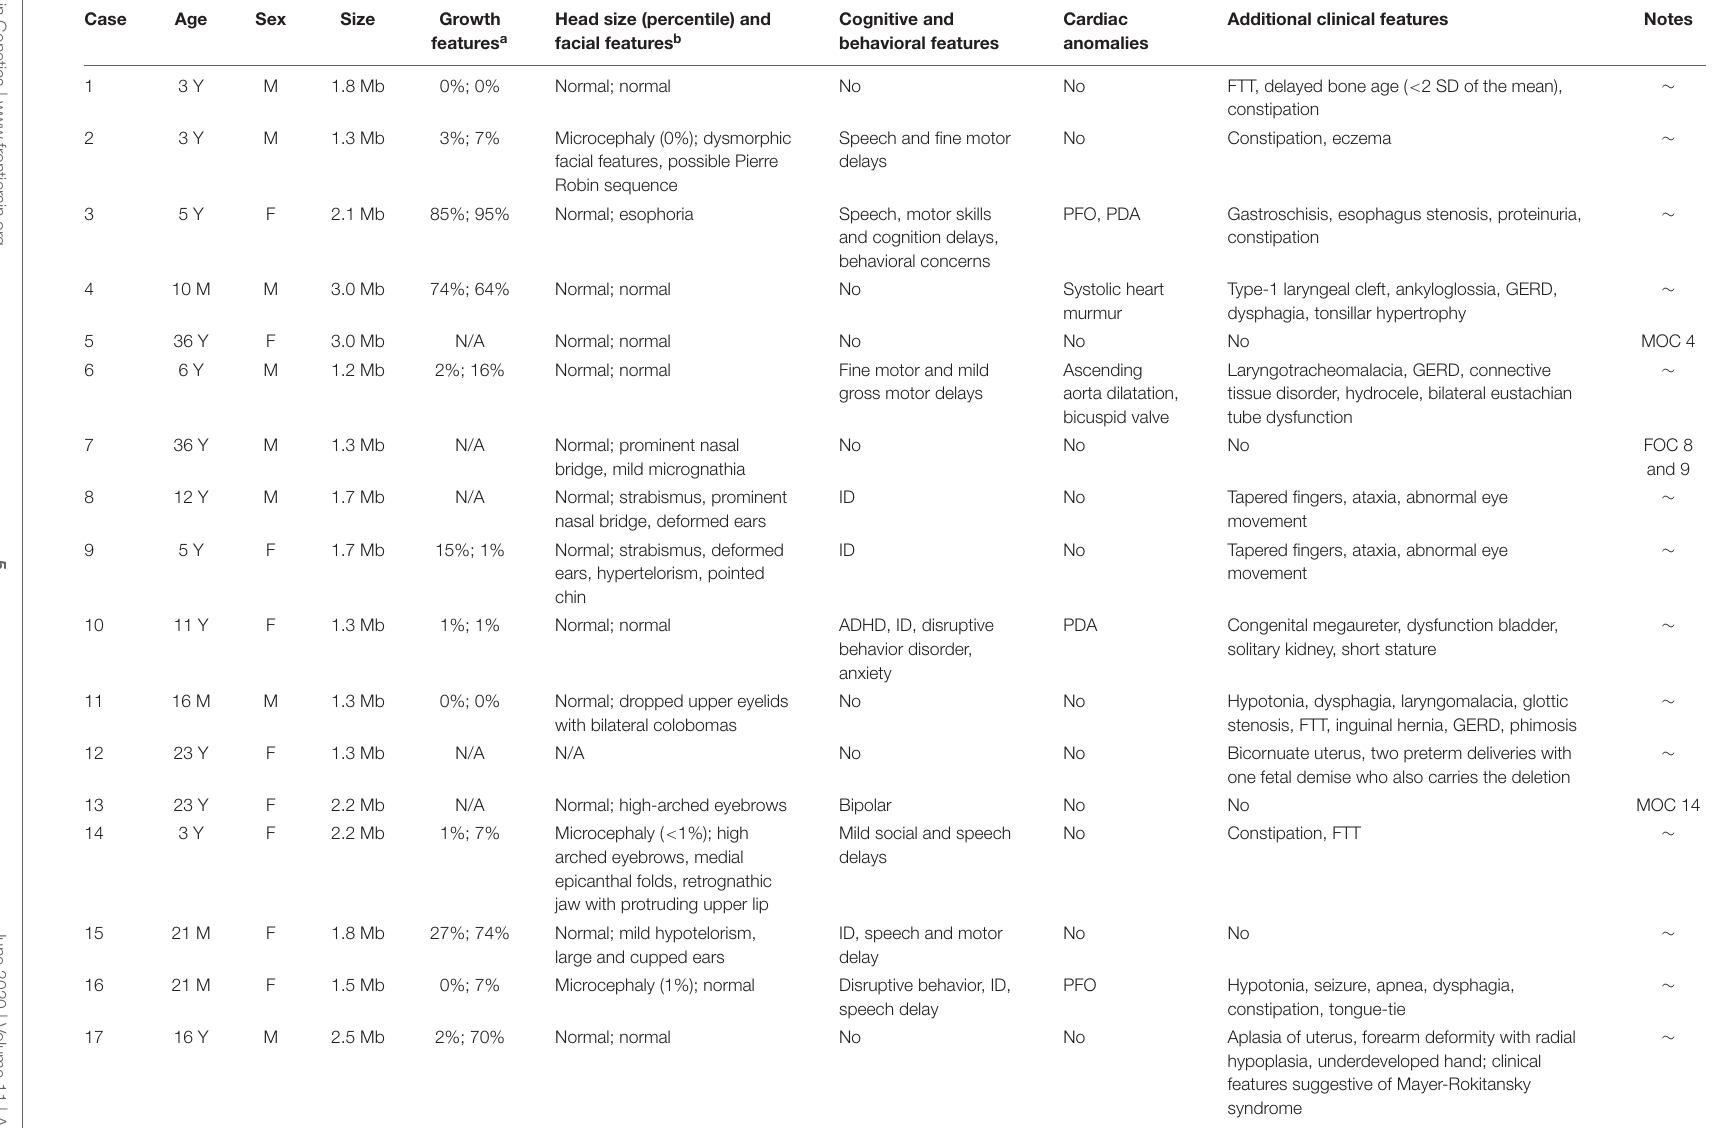
TABLE 1 | Molecular characterization and phenotypical features for individuals with 1q21.1 deletions. Case